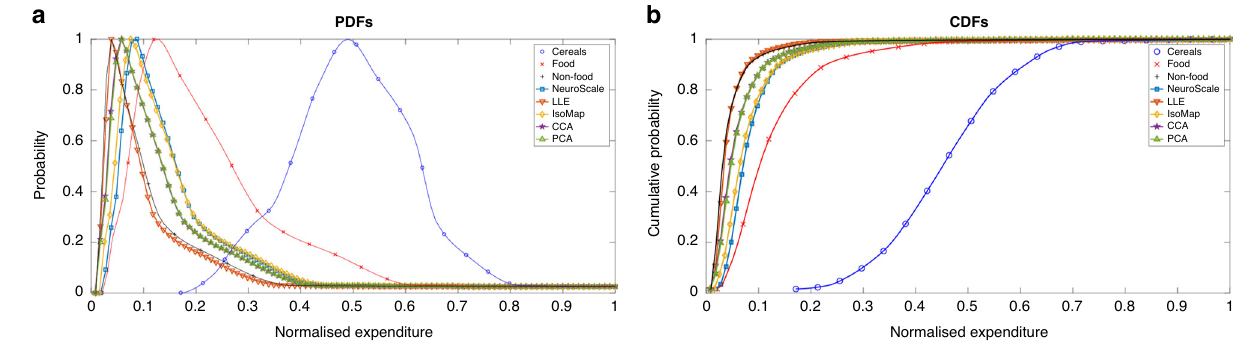
Fig. 3 Probability Density Function (PDF) and Cumulative Distribution Function (CDF). a Probability density functions (PDFs) and b cumulative distribution functions (CDFs), data modeling over 30 years ’ of NSS data (1959 – 1991) 26 . The expenditure on the three categories of cereals (blue circles), other food (red crosses), and non-food (black + ’ s) is shown for comparison. The local methods such as LLE, PCA, and step-CCA focus signi fi cantly on the non-food category, whereas the global mappings of IsoMap and NeuroScale have highest density between the non-food and other food categories. These methods have accounted for the spread of data in more than the single dominant dimension of non-food allowing for a more robust low-dimensional embedding of the data.